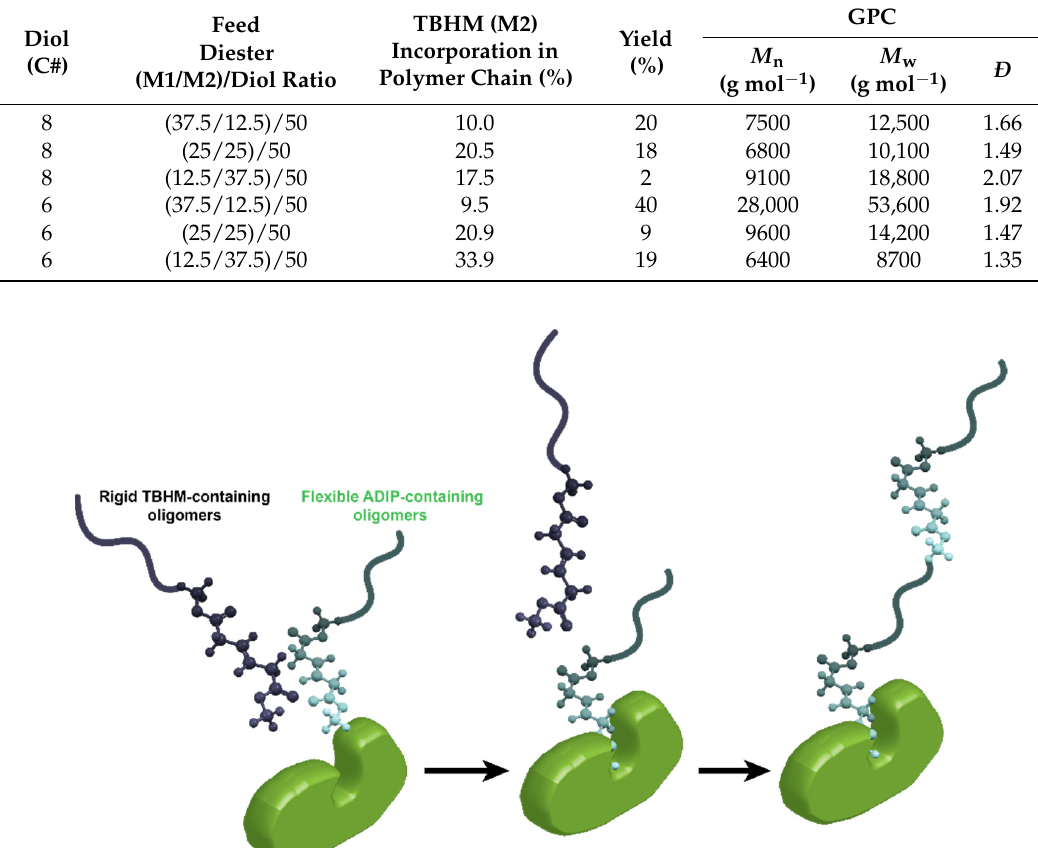
Table 2. Yield and molar mass of copolymers obtained from the polymerization of adipic acid, TBHM, and diols.